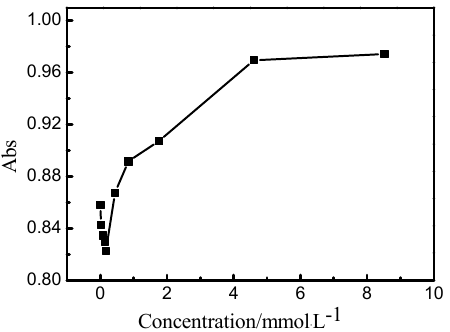
Figure 7. The absorbance intensity of reactive blue 19 with different AEO-3 concentration.